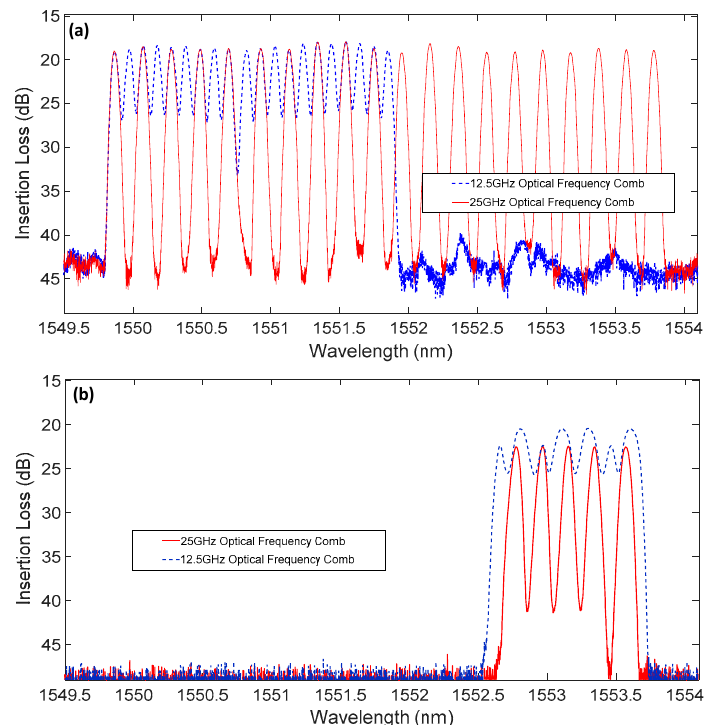
Figure 9. Measured spectra of optical frequency combs (OFCs) with 12.5 GHz and 25 GHz space using ( a ) our 1 × 6 PSP and ( b ) commercial PSP.